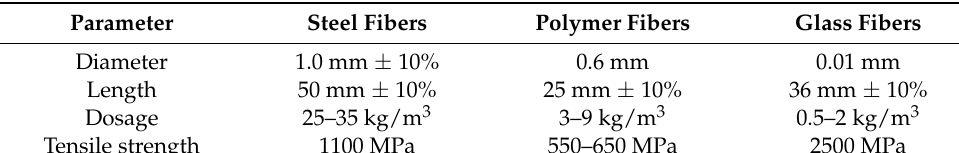
Table 5. Parameters of fibers.